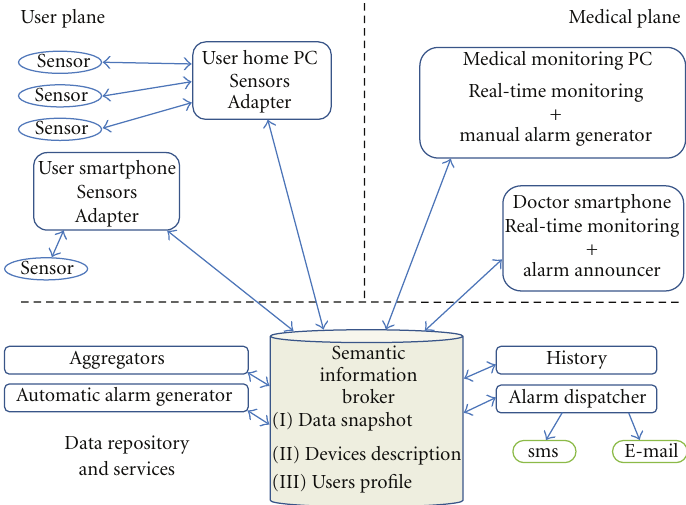
Figure 2: Linking medical and user